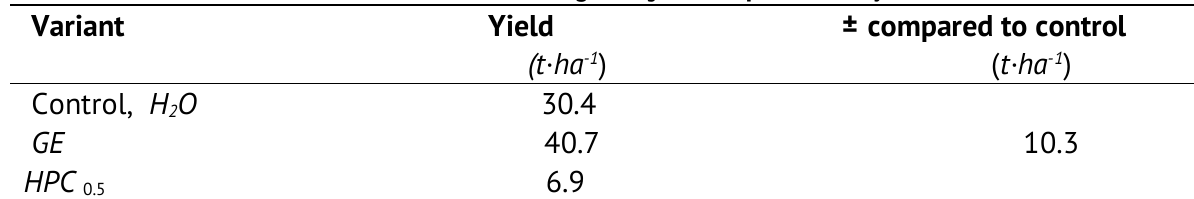
The effect of GE from Linaria genistifolia on productivity of tomatoes.